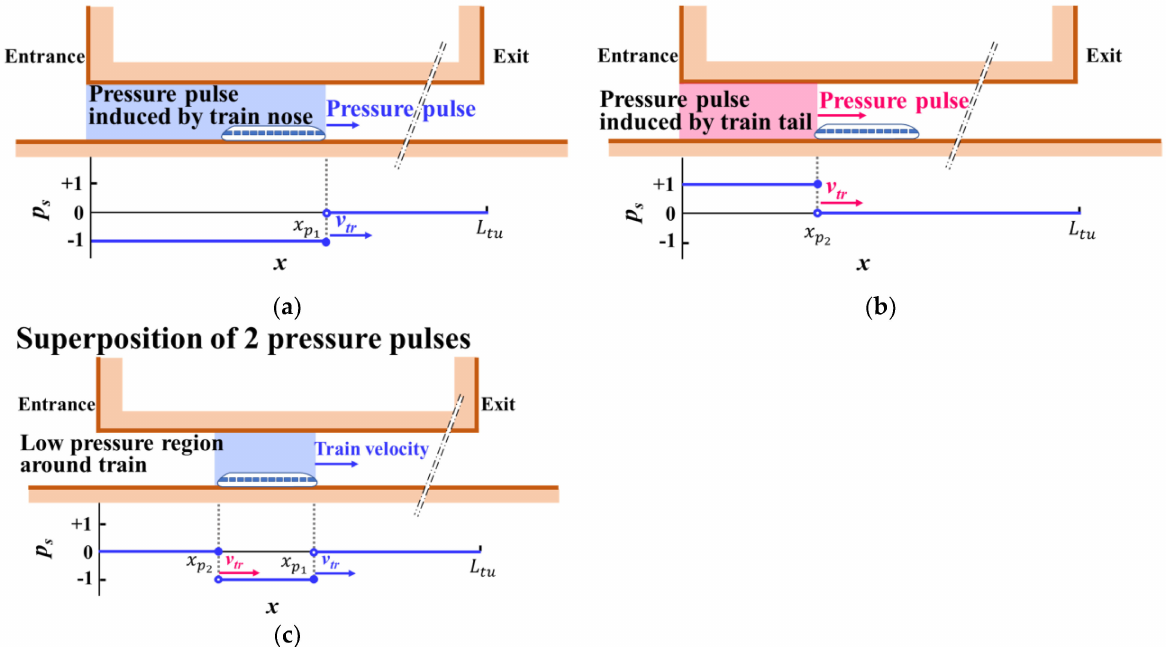
Figure 5. Schematic of p s distribution caused by pressure pulses: ( a ) p s distribution influenced by nose-induced pressure pulses, ( b ) p s distribution influenced by tail-induced pressure pulses, ( c ) p s distribution influenced by 2 pressure pulses ( n w : the reflected times of the wave at the tunnel port; p s : pressure state; x p 1 : the location of pressure pulse induced by train nose; x p 2 : the location of pressure pulse induced by train tail; L tu : tunnel length; v tr : train